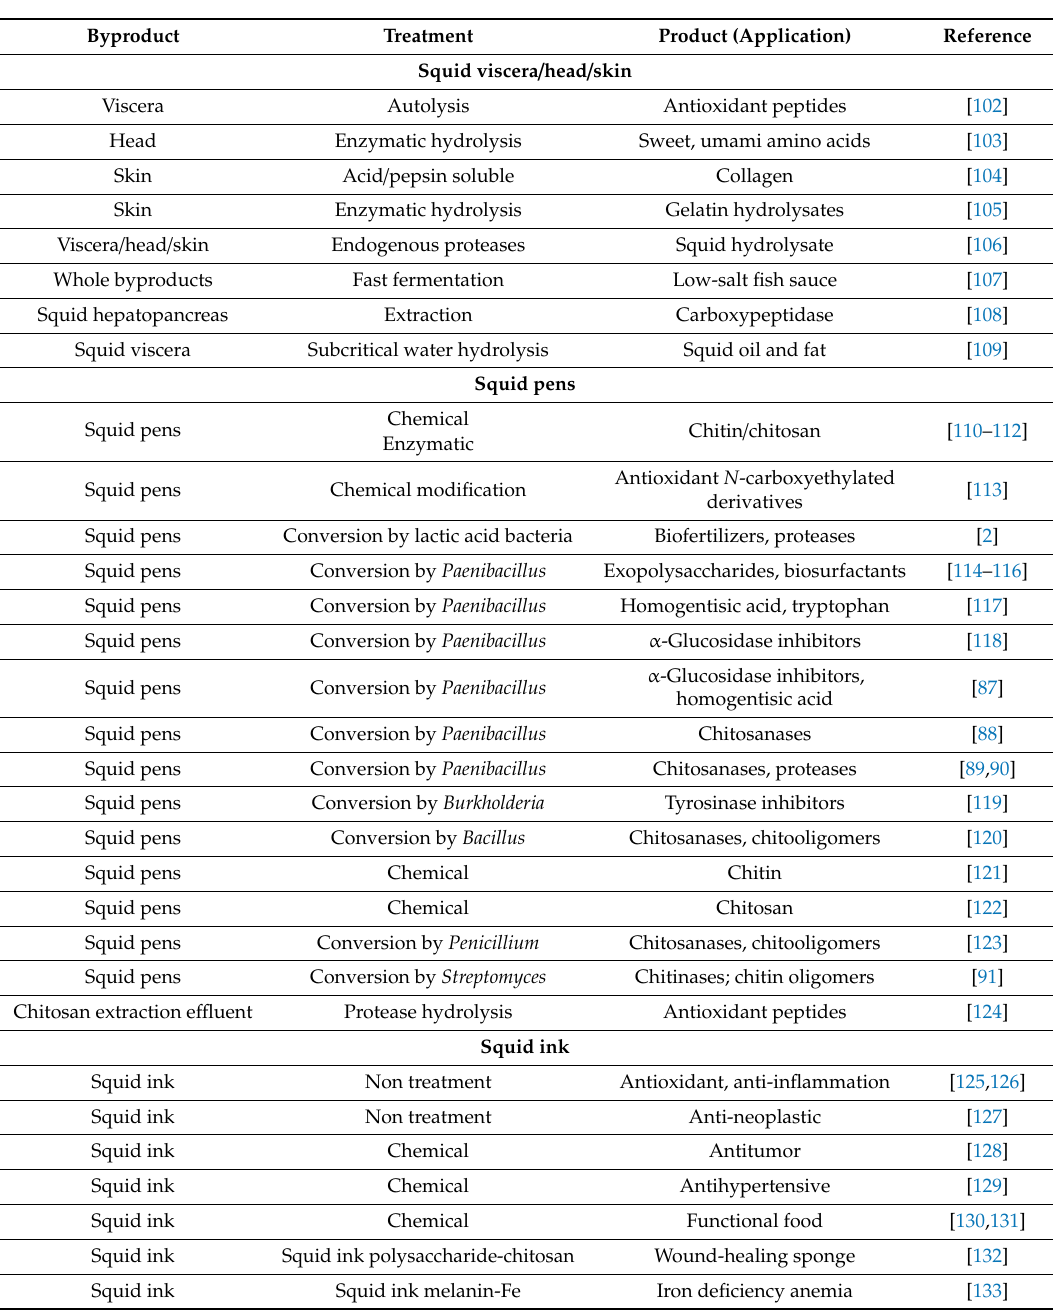
Table 3. Use of squid processing